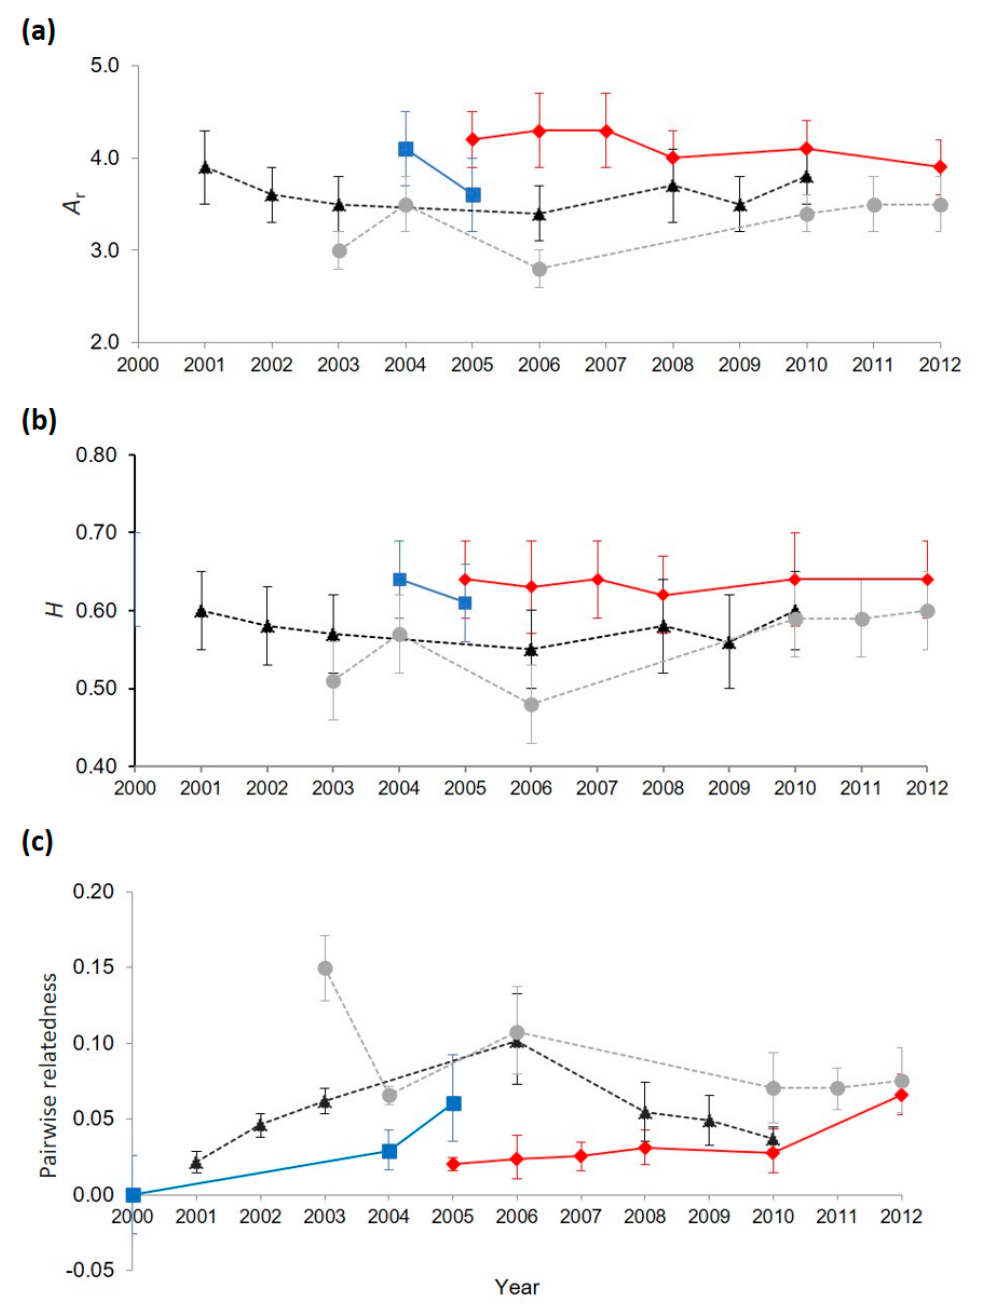
Figure 2. Estimates of ( a ) allelic richness ( A r ); ( b ) gene diversity ( H ); and ( c ) pairwise relatedness within eastern (red) and western (blue) source, captive (black) and reintroduced Peniup Nature Reserve (grey) Parantechinus apicalis populations. Standard error bars are given around the means. Error bars around pairwise relatedness are bootstrapped 95% confidence limits.